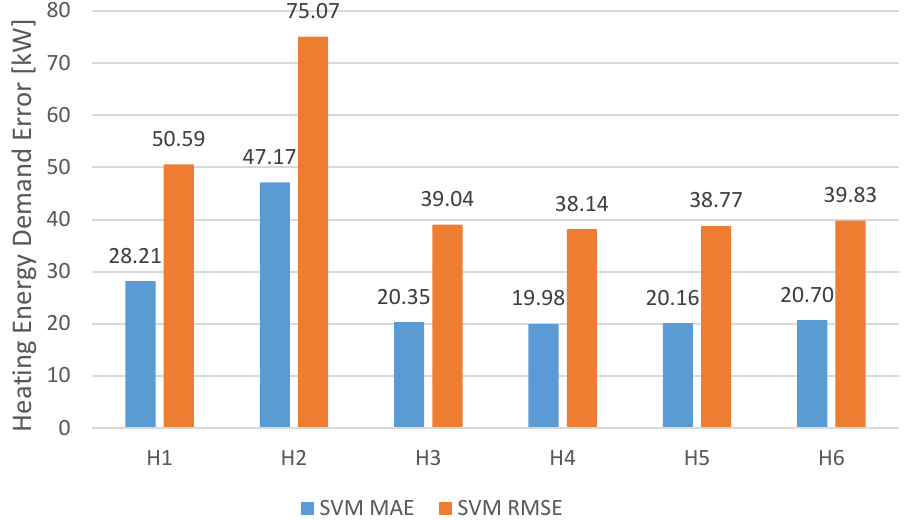
Figure 12. Error metrics for heating energy demand using SVM.